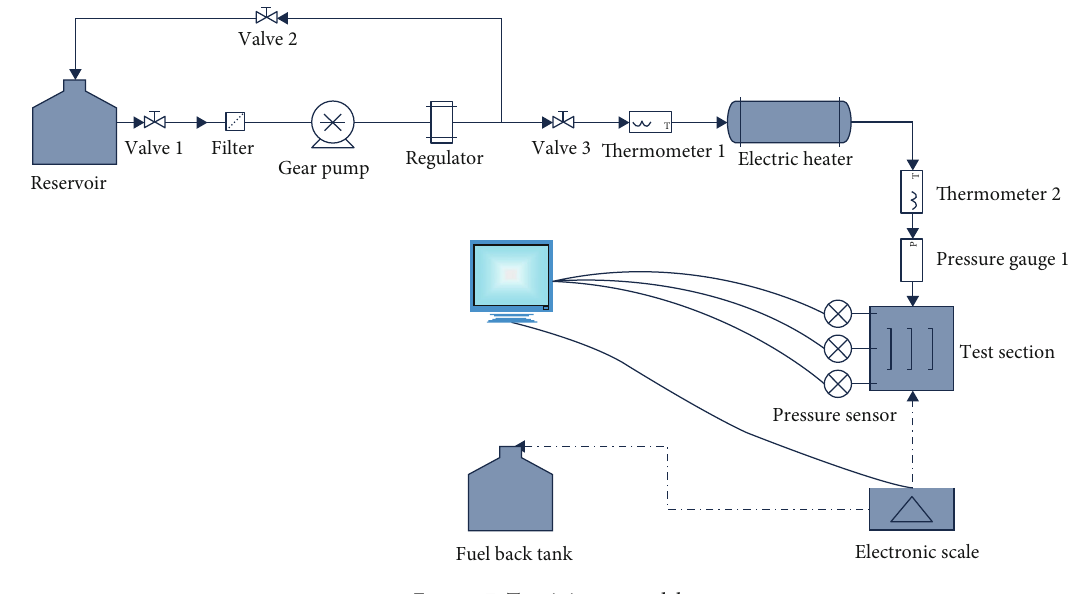
Figure 7: Test injector model. Table 2: Accuracy and range of pressure measuring